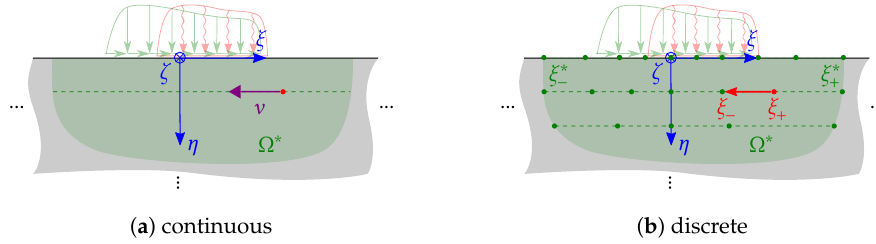
Figure 2. Illustration of the transient step of the residual stress approximation scheme as a continuous process ( a ) and as a corresponding discrete increment ( b ). The green dots in ( b ) represent the spatial discretization Ω ∗ of the domain Ω ∗ on which temperature and thermoelastic stresses are assumed to d be given as input to the thermoelastoplastic approximation